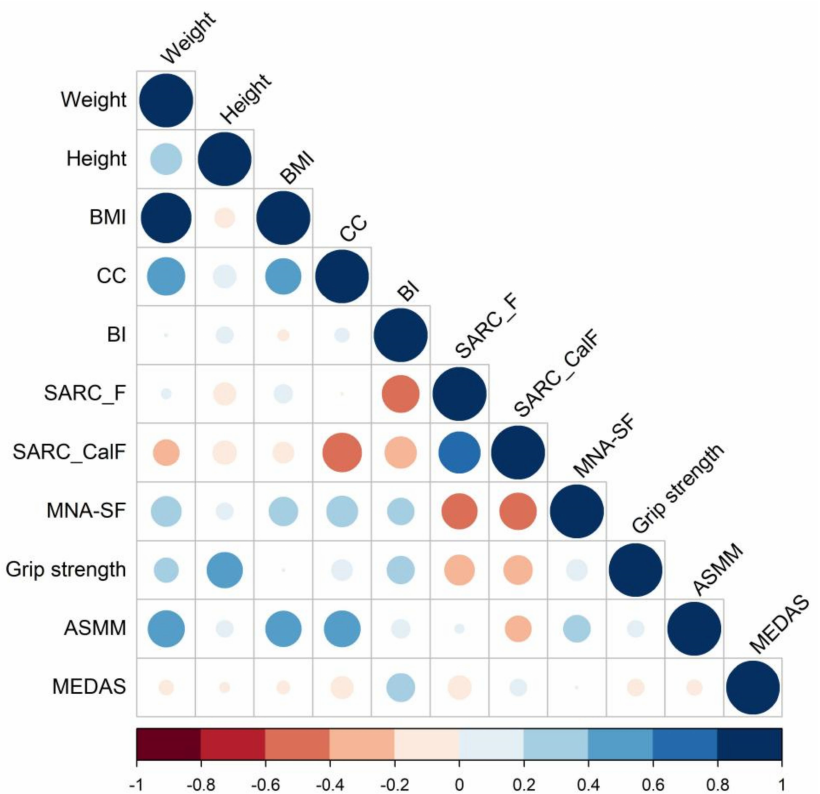
Figure 2. Pearson correlation analysis matrix. ASMM (Appendicular Skeletal Muscle Mass); BI (Barthel Index); BMI (Body Mass Index); CC (Calf Circumference); CCI (Charlson Comorbidity Index); MEDAS (Mediterranean Diet Adherence Screener); MNA-SF (Mini Nutritional Assessment- Short Form). Blue and red colors indicate positive and negative correlations,